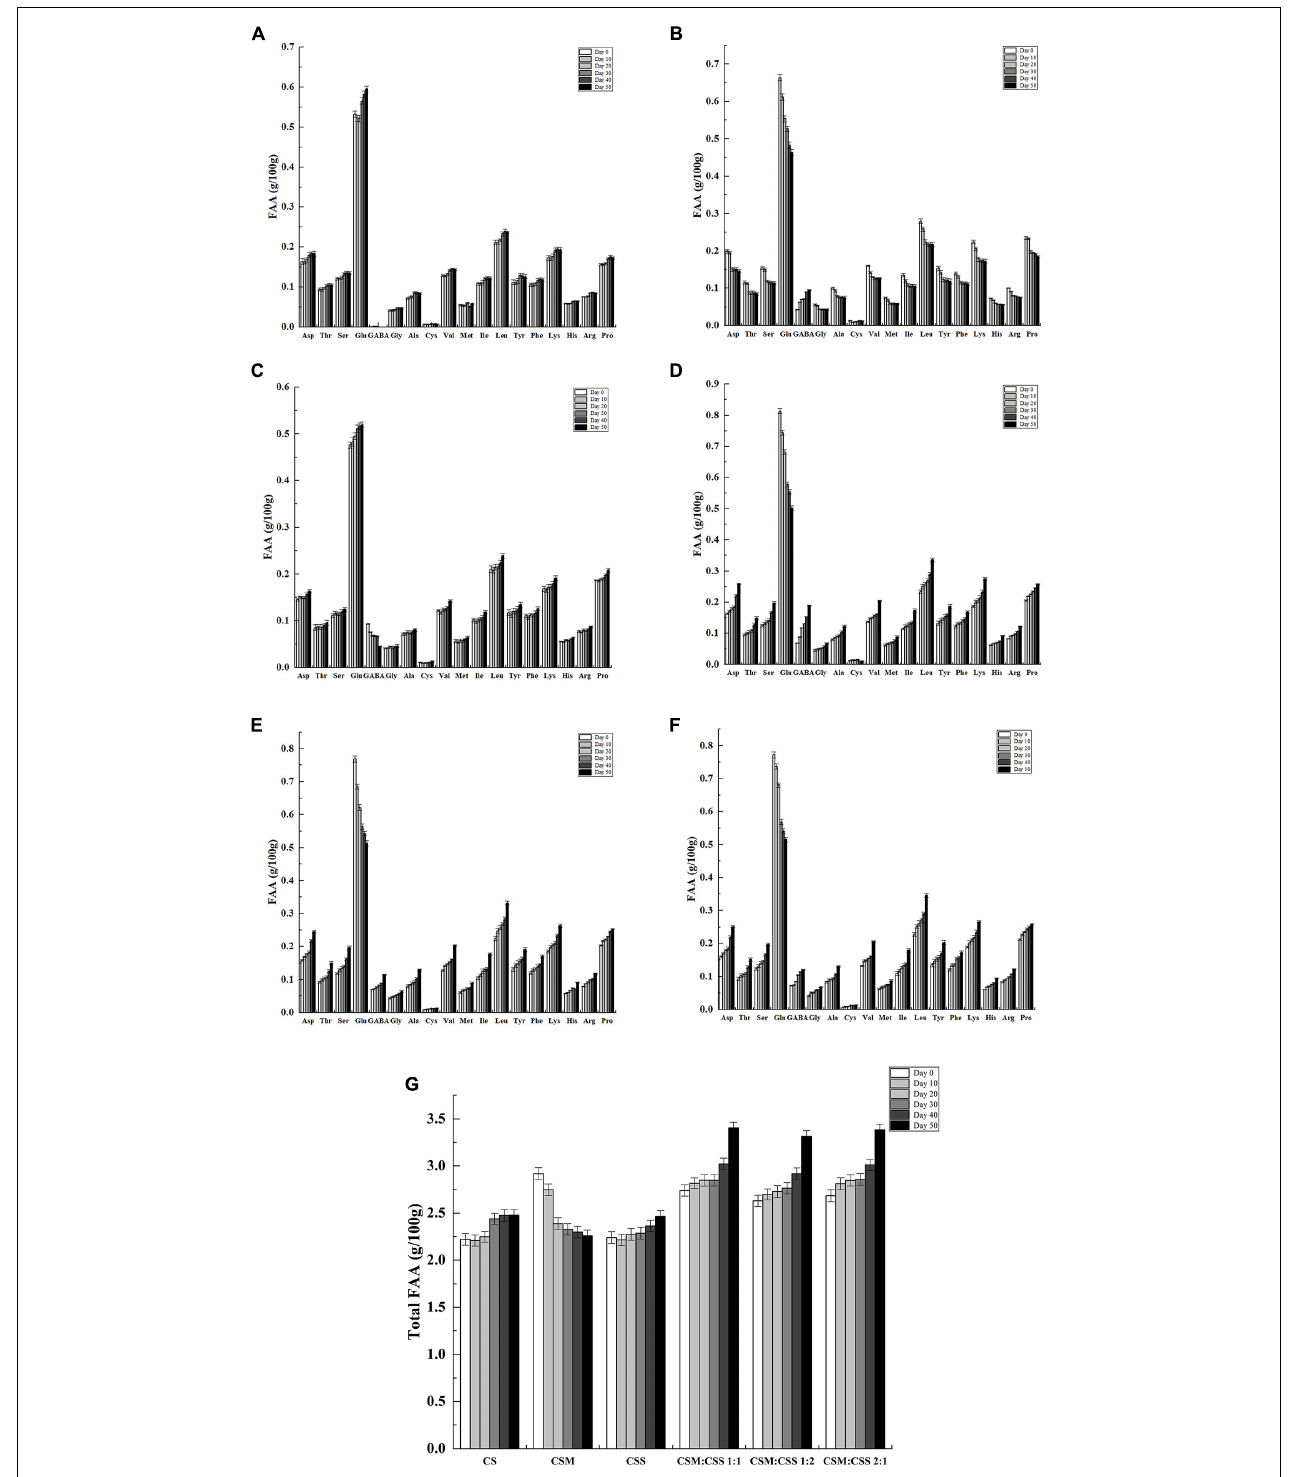
FIGURE 3 | Free amino acid content of the cheeses (g/100 g). CS, CSM, CSS, CSM:CSS 1:1, CSM:CSS 1:2 and CSM:CSS 2:1 represent cheeses fermented using the commercial starter (Control group), K. marxianus B13–5, S. cerevisiae DL6–20, K. marxianus B13–5: S. cerevisiae DL6–20 1:1, K. marxianus B13–5: S. cerevisiae DL6–20 1: 2, and K. marxianus B13–5: S. cerevisiae DL6–20 2:1. (A–F) FAA content of CS, CSM, CSS, CSM:CSS 1:1, CSM:CSS 1:2 and CSM :CSS 2:1. (G) Represents the change in the total content of FAA in different cheeses. Error bars indicate standard deviations.